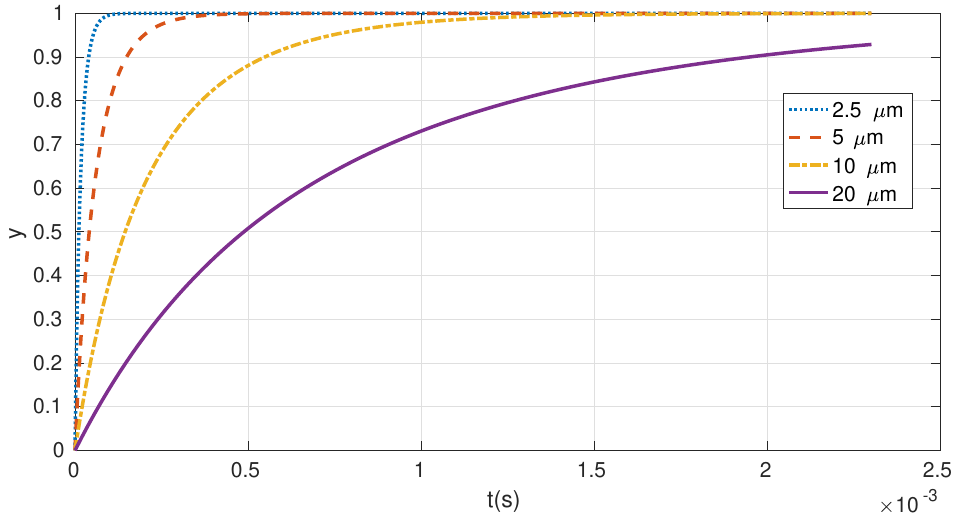
Figure 3. The same as in Figure 2 plotted for aerosol particles moving at intermediate regime. Aerosols of these sizes are still airborne transmittable over long